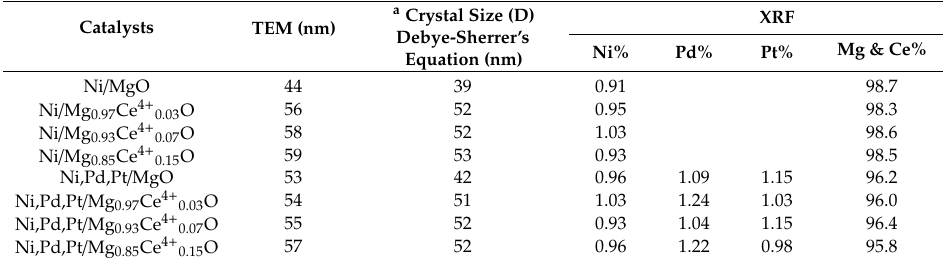
Table 1. XRD, TEM, and XRF results for the measurement of particle